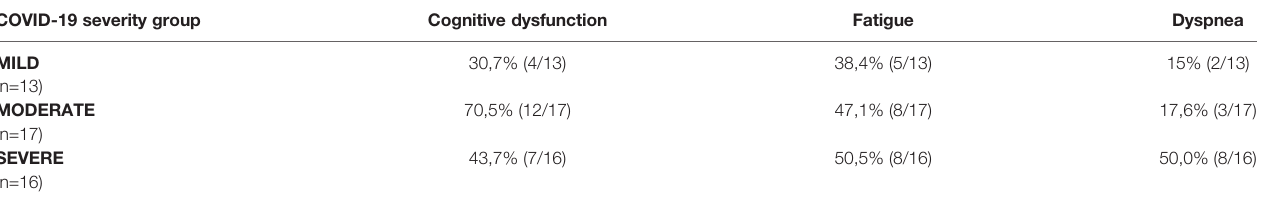
Data have been collected during an interview made by a